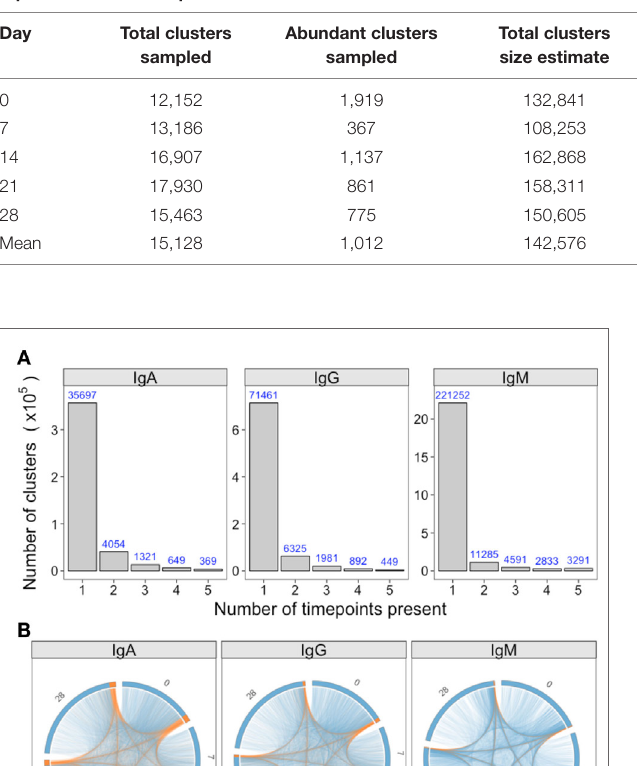
TaBle 1 | number of total clusters, and abundant clusters for the igg 1 sample at each timepoint from participant aF01, size estimates of the total igg and abundant igg cluster repertoire based on capture-recapture analysis of biological replicates, and the percent of the total repertoire, and abundant repertoire that we sequenced.